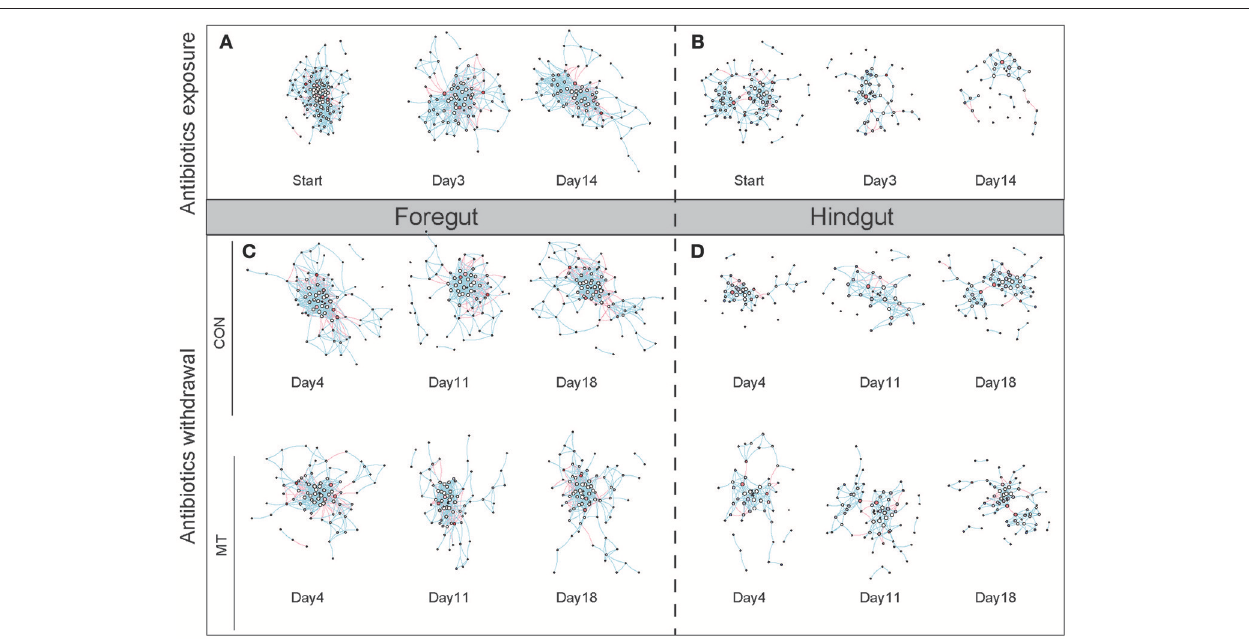
FIGURE 7 | The co-occurrence network change in foregut and hindgut after antibiotics exposure and antibiotics withdrawal. (A) The co-occurrence network change in foregut after antibiotics exposure. (B) The co-occurrence network change in hindgut after antibiotics exposure. (C) The co-occurrence network change in foregut after antibiotics withdrawal. (D) The co-occurrence network change in hindgut after antibiotics withdrawal. The nodes represented high-confidence OTUs in each sub-data sets, the size of each node represented the node degree value, the color of each node represented the node vulnerability value. The edge stands for significant correlation between two nodes ( P < 0.001), the edge color represented negative (red) or positive (blue) correlation of two connected